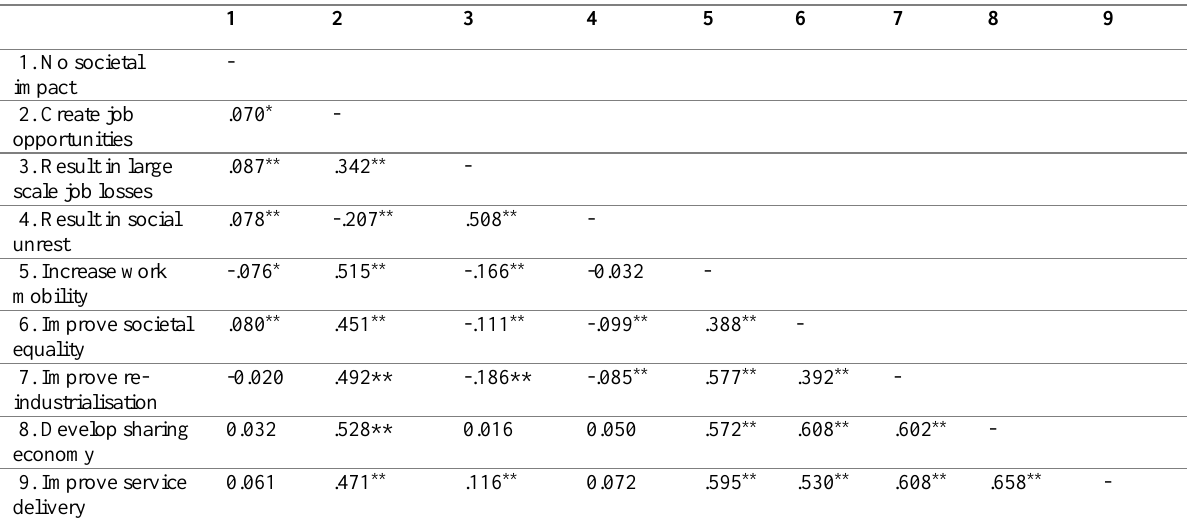
Table 4: Spearman’s rank correlation relationship between the fourth industrial revolution impact